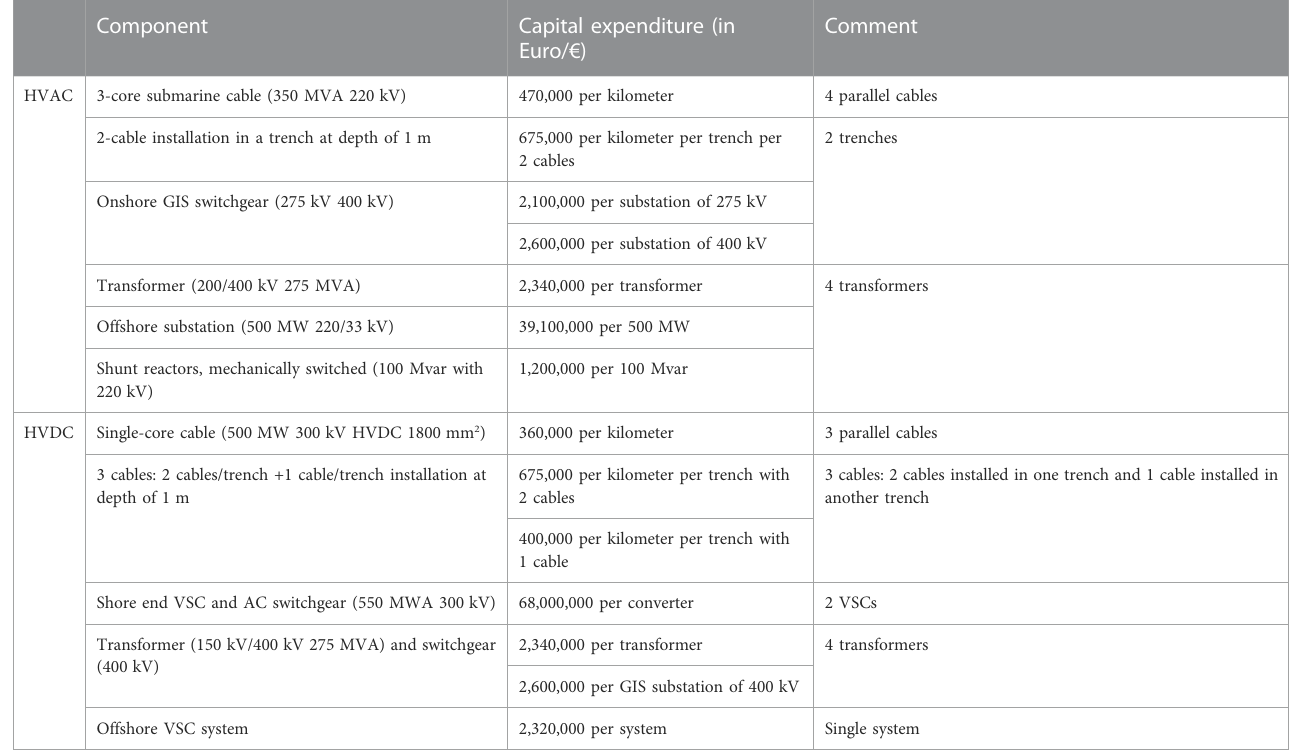
TABLE 2 Comparison of HVAC and HVDC in terms of their capital costs (Li et al., 2021).